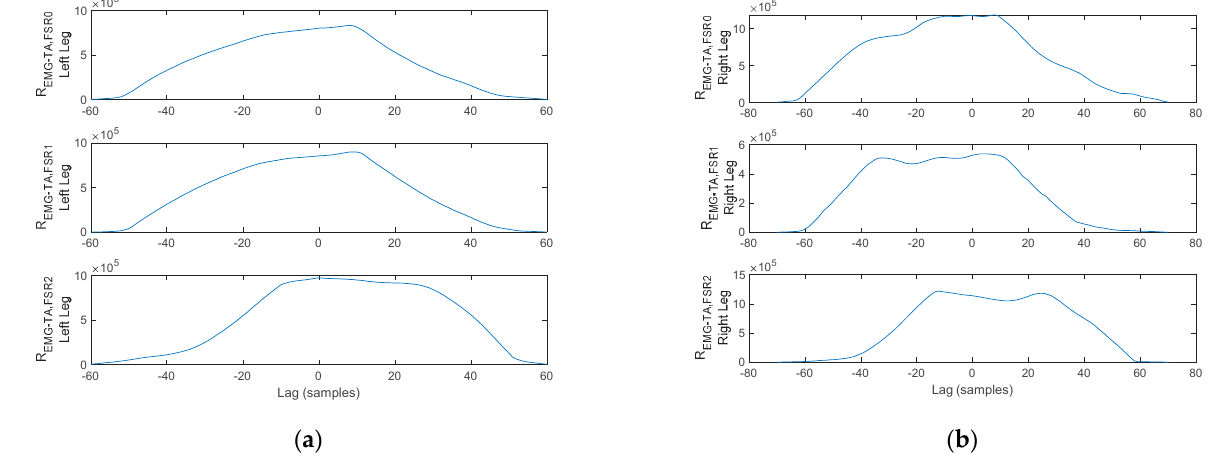
Figure 22. Cross-correlation of the TA and FSR signals plotted in Figure 21 for the ( a ) left foot and ( b ) right foot.